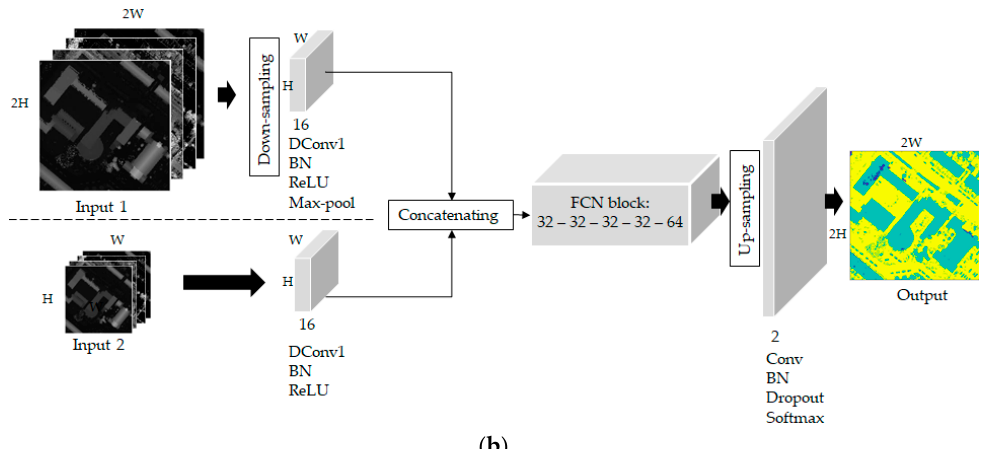
Figure 5. The proposed multi-scale networks: ( a ) Multi-Scale (MS)-FCN Down (without up-sampling layer); ( b ) MS-FCN Down–Up (with up-sampling layer).